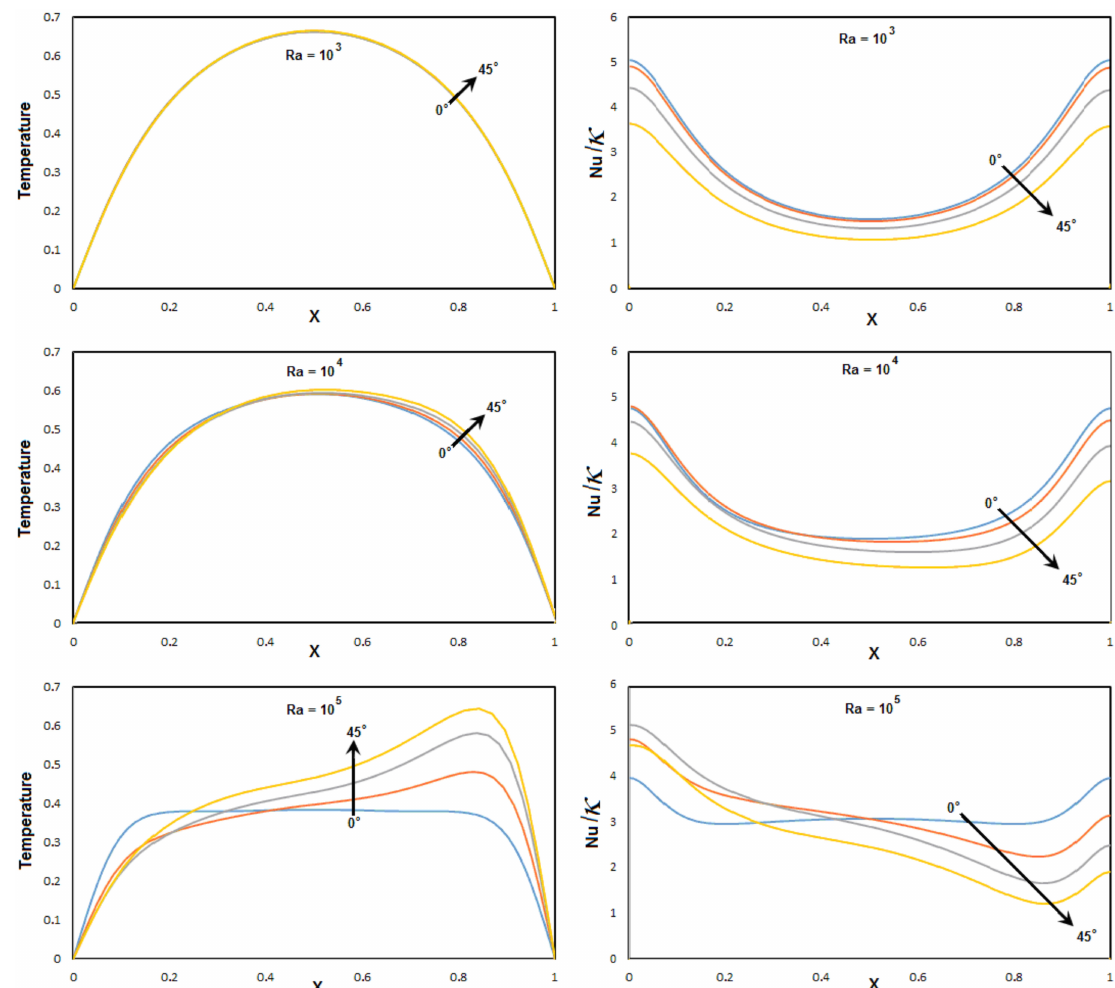
Figure 8. Nanofluid temperature and Nu / κ evolutions at the levels: Y = 0.5 ( right ) and Y = 1 ( left )